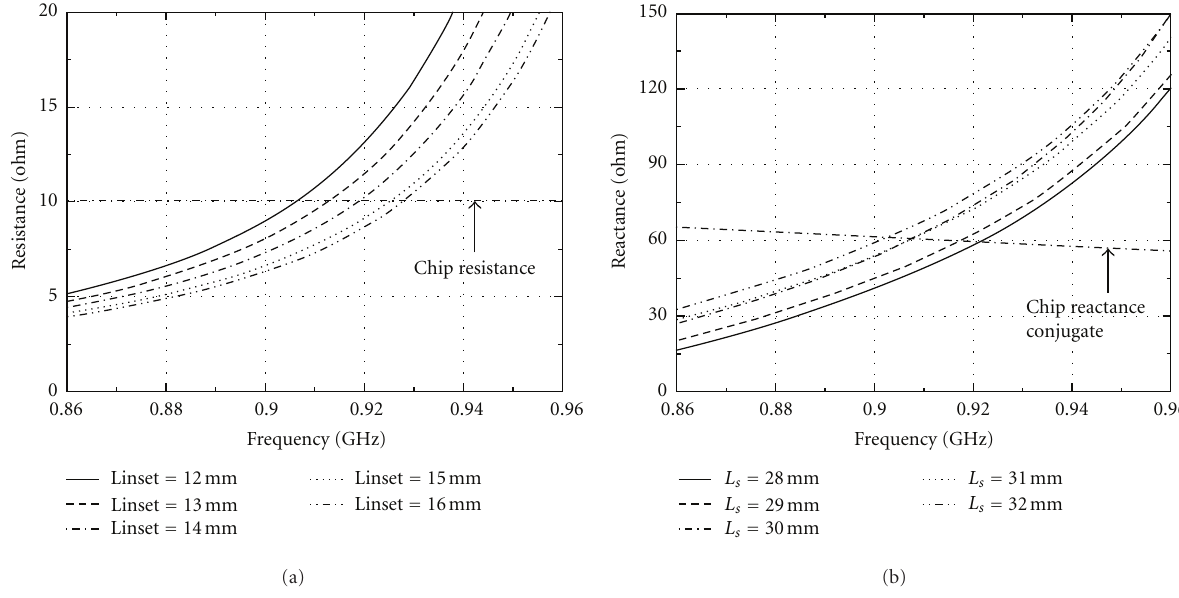
Figure 5: Antenna input impedance tuning. (a) Input resistance curves of the antenna with di ff erent inset depths L inset ( L = 37mm, W = 20mm, h = 3mm, L s = 30mm). (b) Input reactance curves of the antenna with di ff erent open stub length L s ( L = 37 mm, W = 20 mm, h = 3mm, L = 14 mm). inset